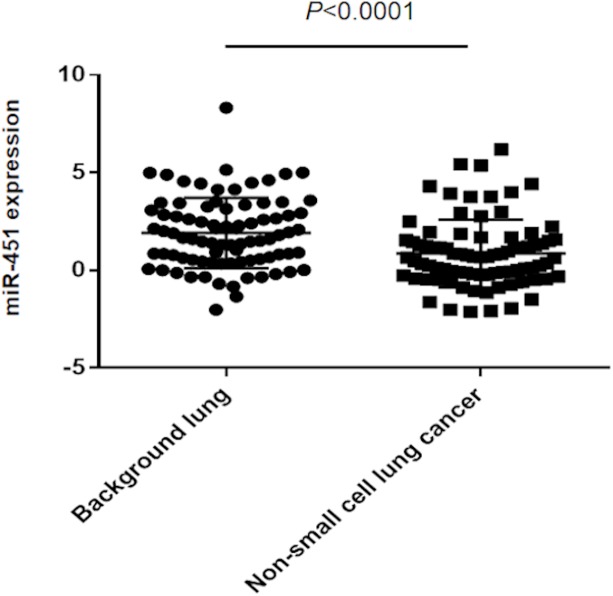
miR-451 expression in paired background lung and non-small cell lung cancer tissues.The miR-451 expression is significantly lower in NSCLC tissues than in background lung tissue (P<0.0001 with paired t-test). Y-axis: -δCt = -(Ct miR-451−Ct RNU6B).